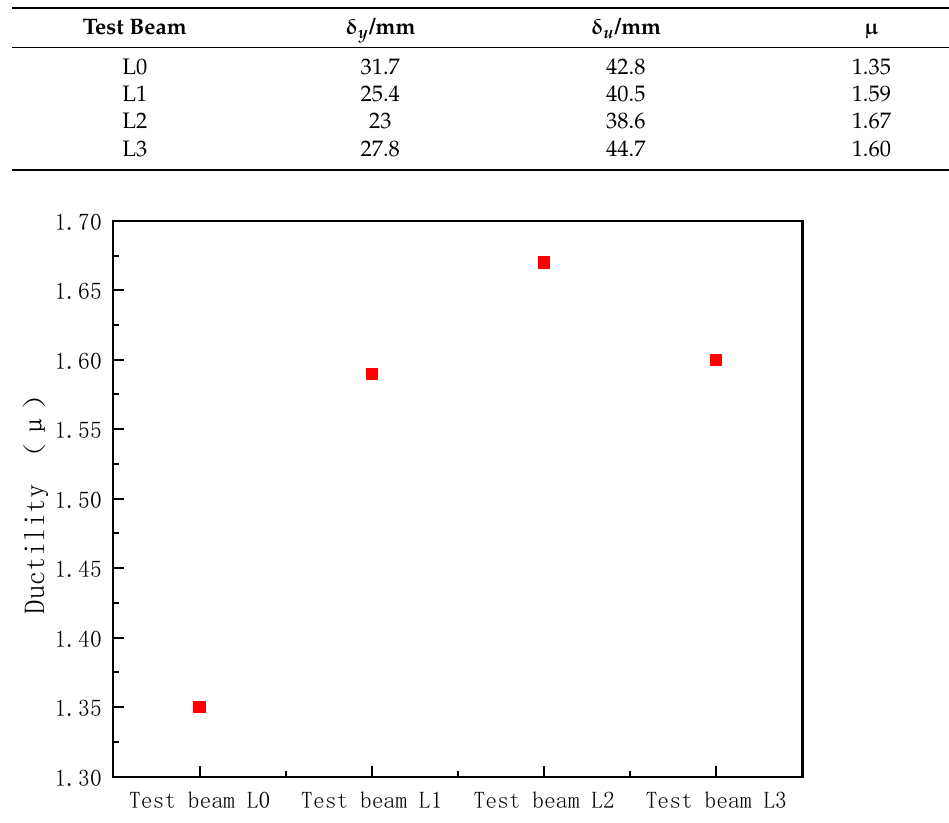
Table 6. Ductility test results of each test beam.